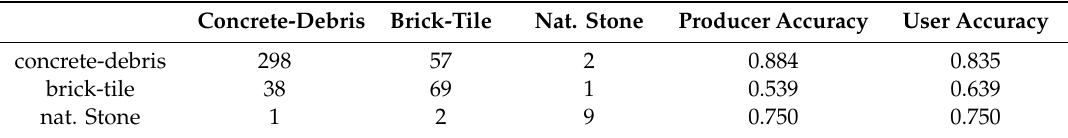
Table 5. Accuracy parameters of three recoded PED maps obtained using the 0.35 PMA threshold (477 samples) . Table 6. Accuracy parameters of three recoded PED maps obtained using the 0.45 PMA threshold (252